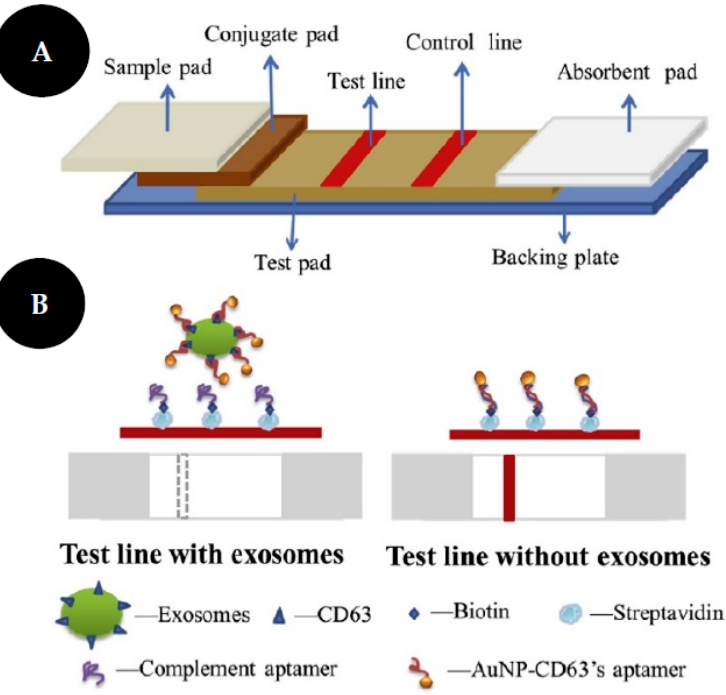
Figure 10. Scheme of LFA test strips ( A ). Scheme of competitive LFA with aptamer as recognition elements for exosome identification ( B ). Reproduced and adapted with permission from [37].